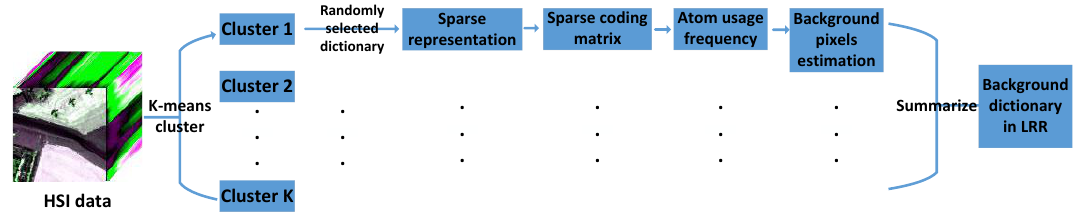
Figure 2. Illustration of the background dictionary construction